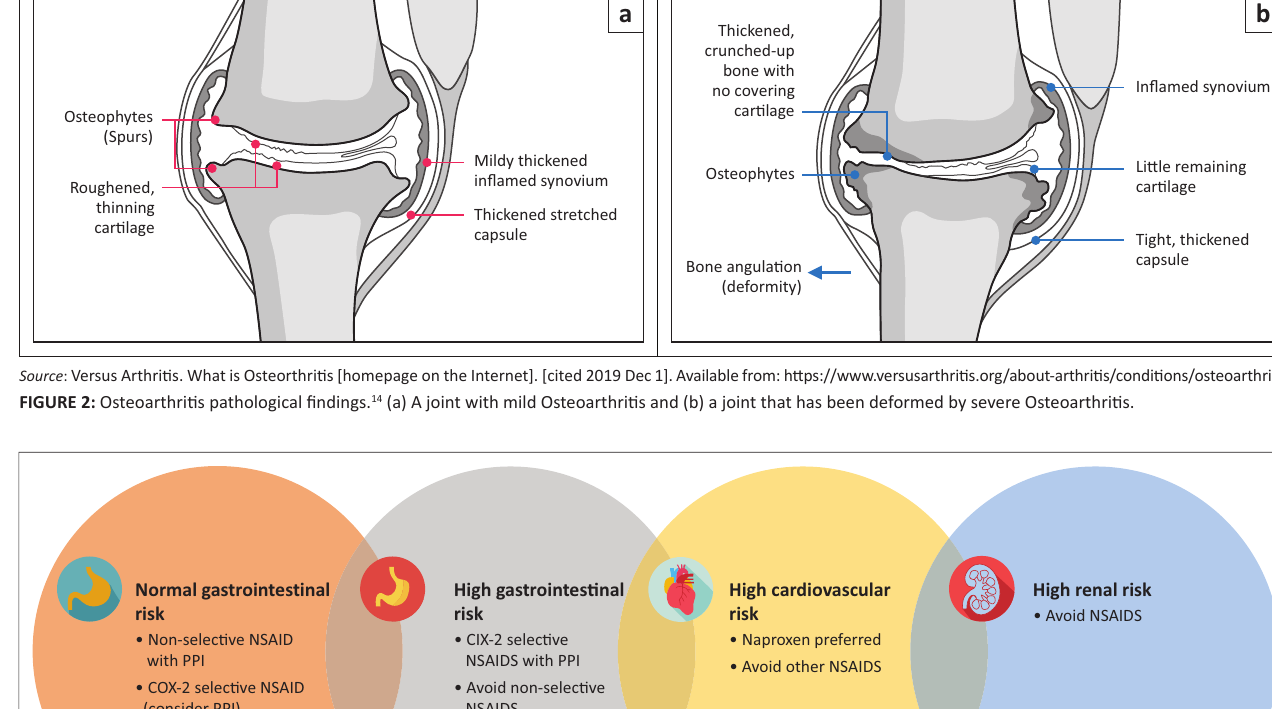
Normal gastrointestinal risk